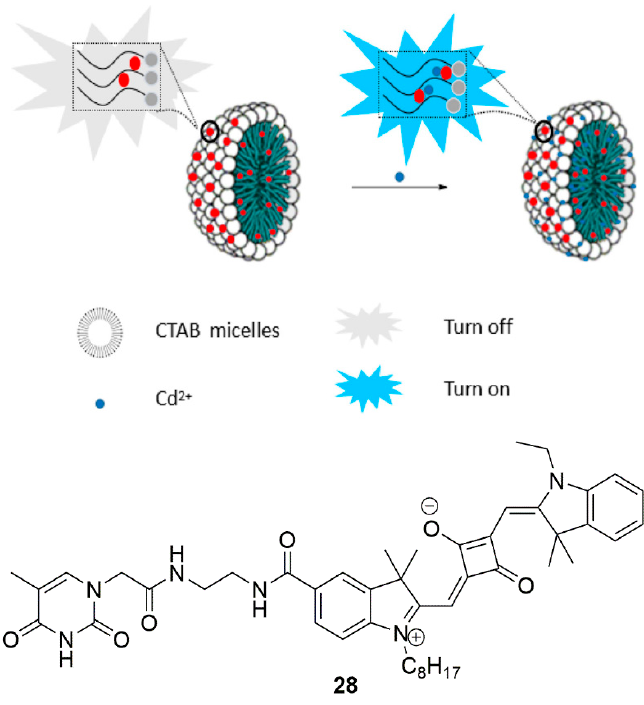
Figure 11. The proposed intermolecular interaction between compound 28 and the Cd 2 + ions encapsulated in the micelle. Adapted and reprinted from [183], with permission from Elsevier. Two turn-“on” fluorescent sensors compounds 29a and 29b were synthesized by Xu and coworkers, Scheme 12 [186]. Both compounds could bind both Zn 2+ and Cd 2+ ions in a CH 3 OH/H 2 O solution (1:1, v/v, Tris, 10 mmol ⋅ L − 1 , pH 7.4). These molecular probes displayed a weak fluorescence